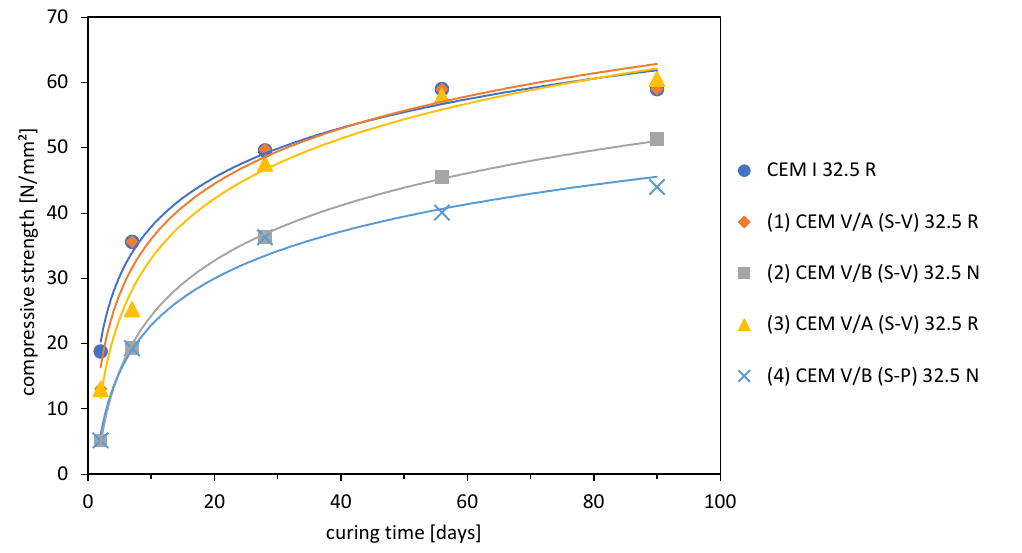
Figure 4. Compressive strength development of standard mortar specimens according to [51] (each value as a mean value of 3 individual tests), after 2, 7, 28, 56, and 90 days.